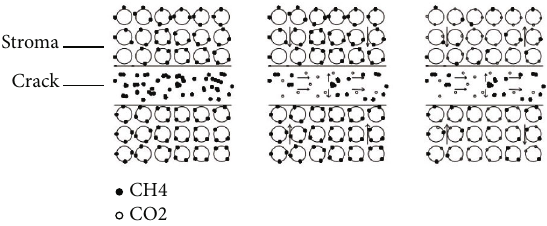
Figure 10: Replacement process of ECBM.